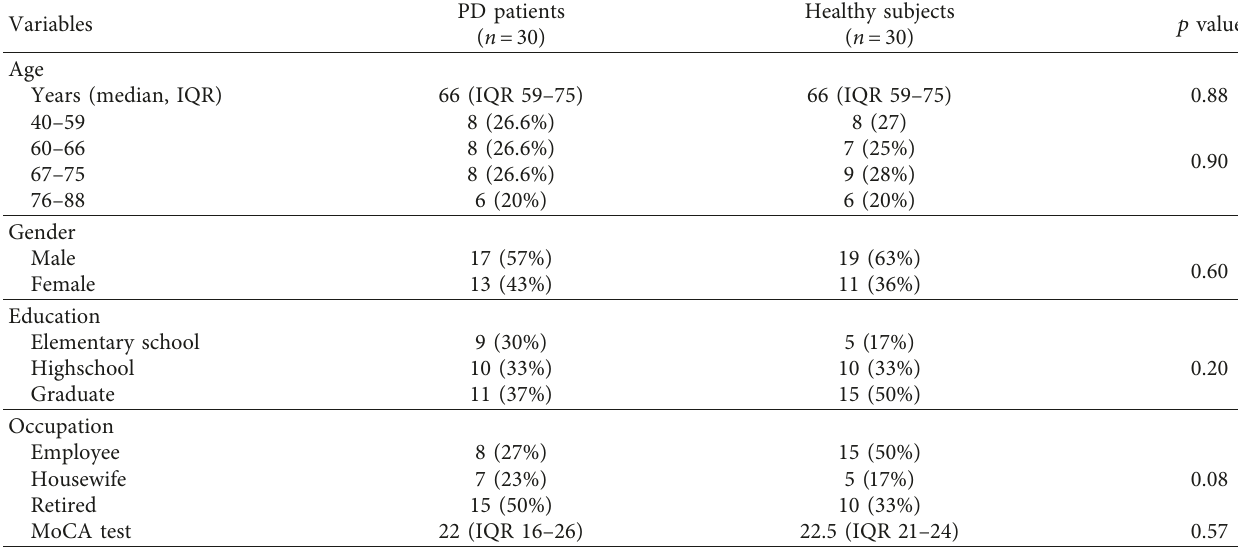
Table 1: Clinical background and characteristics of the